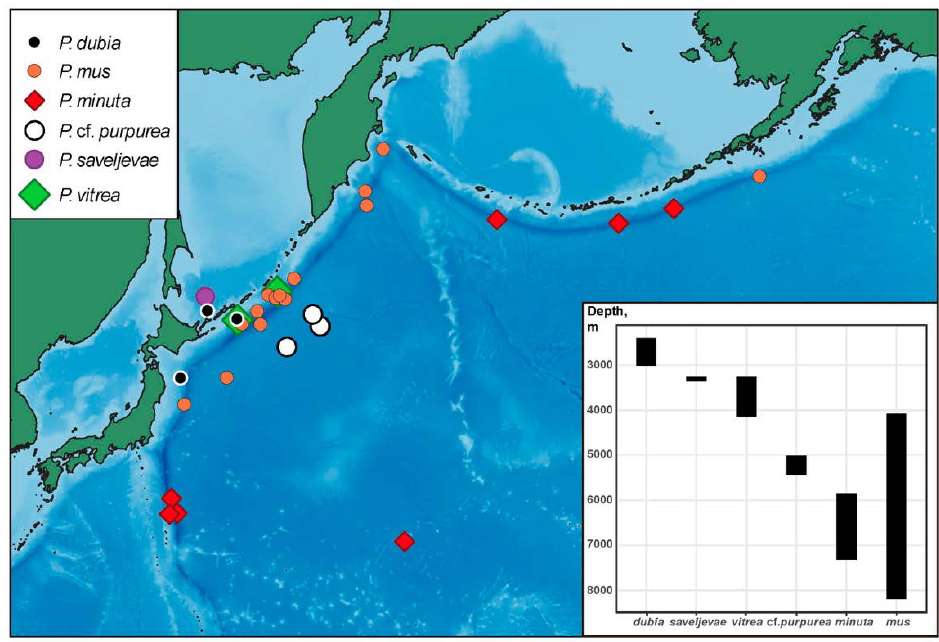
Figure 11. Geographic distribution and bathymetric range of the examined species in the northwest Pacific.